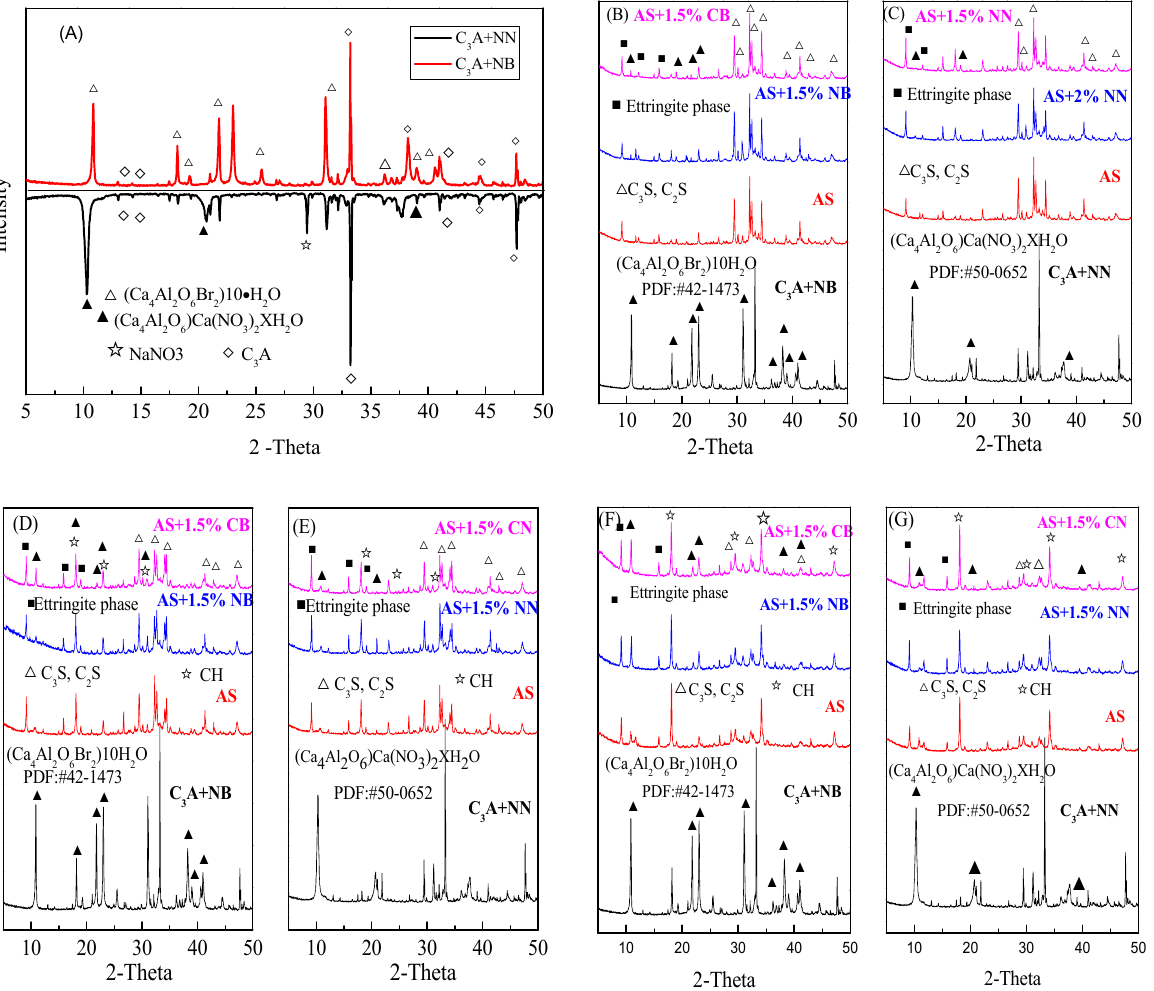
Figure 5. XRD of hydration products: ( A ) C 3 A + nitrate ions and C 3 A + bromine ions hydrated samples; ( B ) hydration product of the cement paste added with bromide for 12 h; ( C ) hydration product of the cement paste added with nitrate for 12 h; ( D ) hydration product of the cement paste added with bromide for 24 h; ( E ) hydration product of the cement paste added with nitrate for 24 h; ( F ) hydration product of the cement paste added with bromide for 28 d; ( G ) hydration product of the cement paste added with nitrate for 28 d.